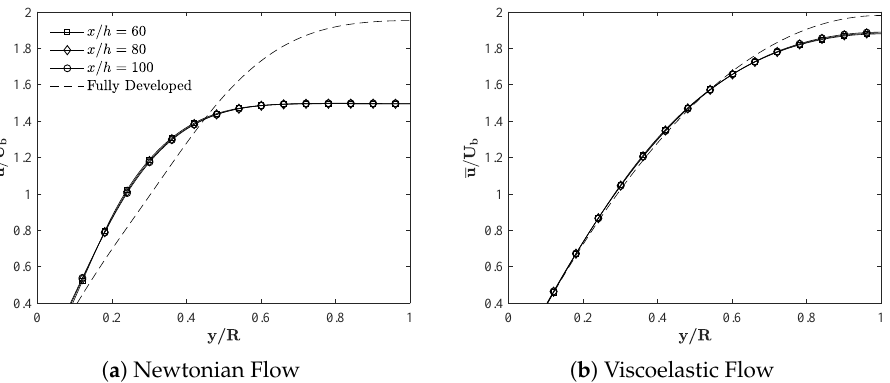
Figure 6. Mean axial velocity profiles ( u / U b ) at different axial locations ( x / h = 60,80 and 100) for h / D =